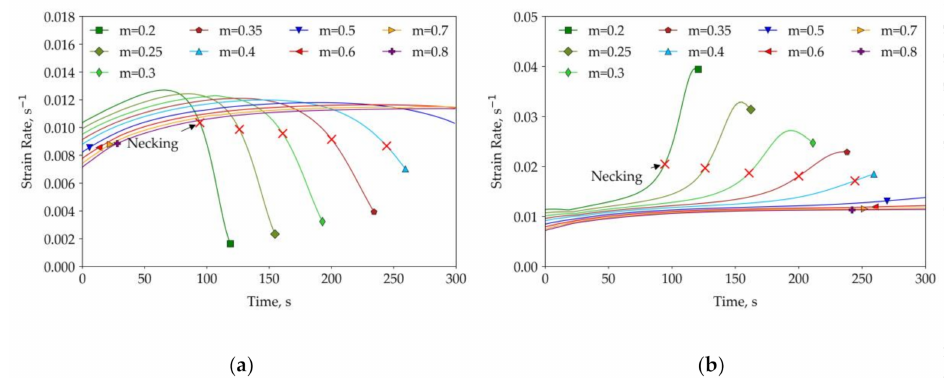
Figure 6. The e ff ect of strain-rate sensitivity ( m ) on the strain-rate evolution: ( a ) the evolutions of the strain rate in the specimen center obtained for di ff erent m values; ( b ) the evolutions of the maximum strain rate for di ff erent m values.